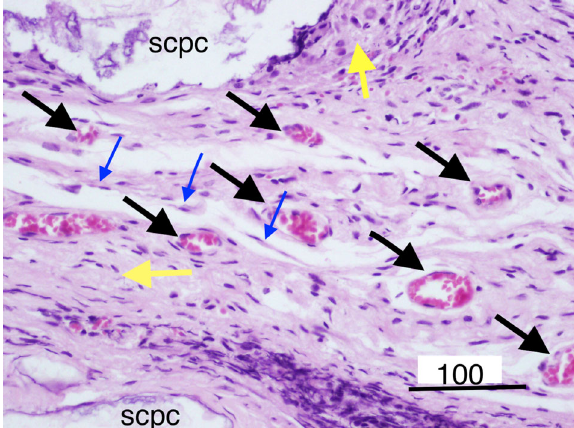
Fig. 4 Photomicrographs showing decalci fi ed histological sections of Group 1 (DSM/SCPC/hBMSC) stained with H&E. Areas of bone growth within the corticoid defect as well as the onlay graft are evi- dent. New woven bone bridges the defect and grows upward. Remnant SCPC granules can be seen with high cellular activity around them and direct bone deposition on the material surface. Numerous blood ves- sels (black arrows) are recognised close to the SCPC particles. Islands of mature bone can be seen surrounded by high cellular activity and immature bone and loose connective tissue as periosteium-like struc- ture (blue arrow), Scale bar = 100 μ